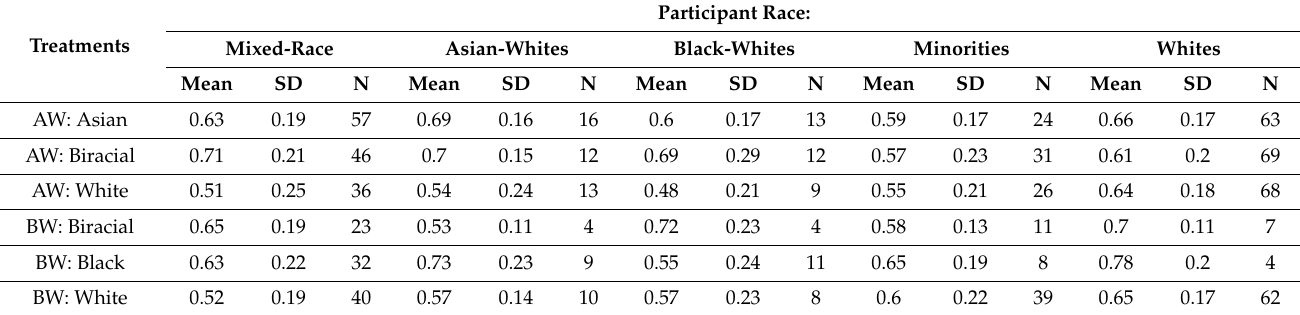
Table A2. (Feeling Thermometer) Mean, standard deviation, and sample size information for each treatment condition × participant race